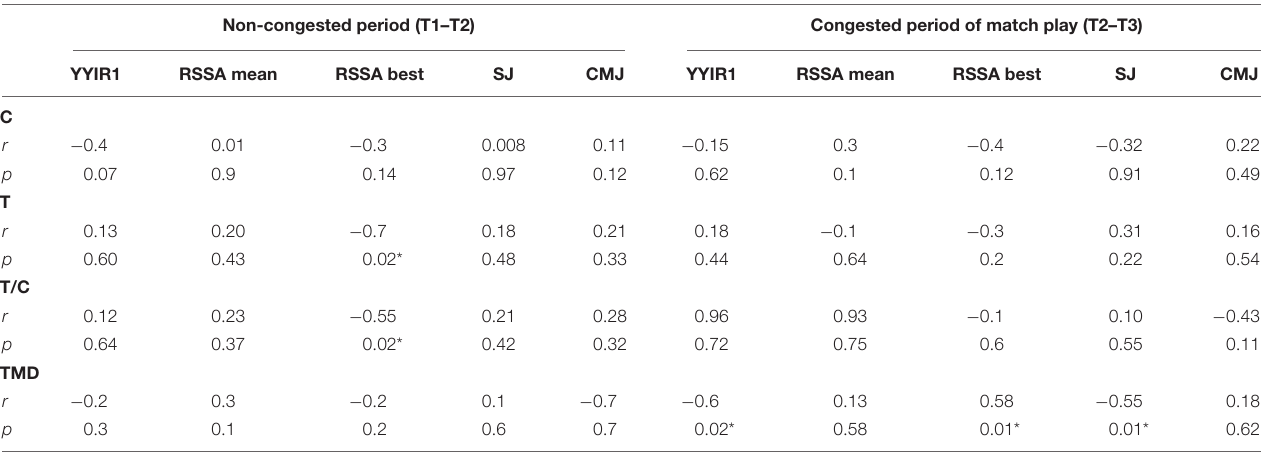
TABLE 8 | Relations between hormonal parameters, and psychological parameters with measures of physical fitness.